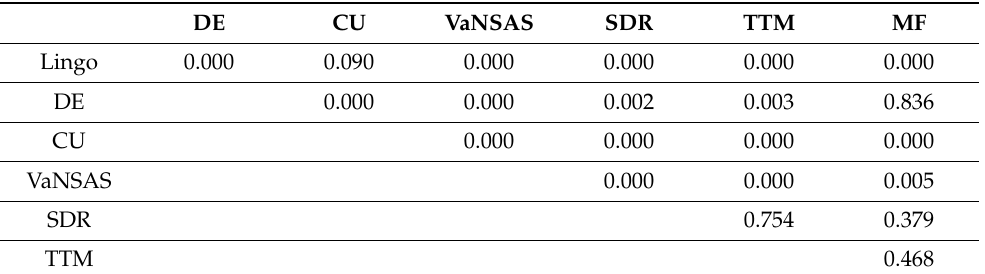
Table 14. Statistical test of objective function for large test